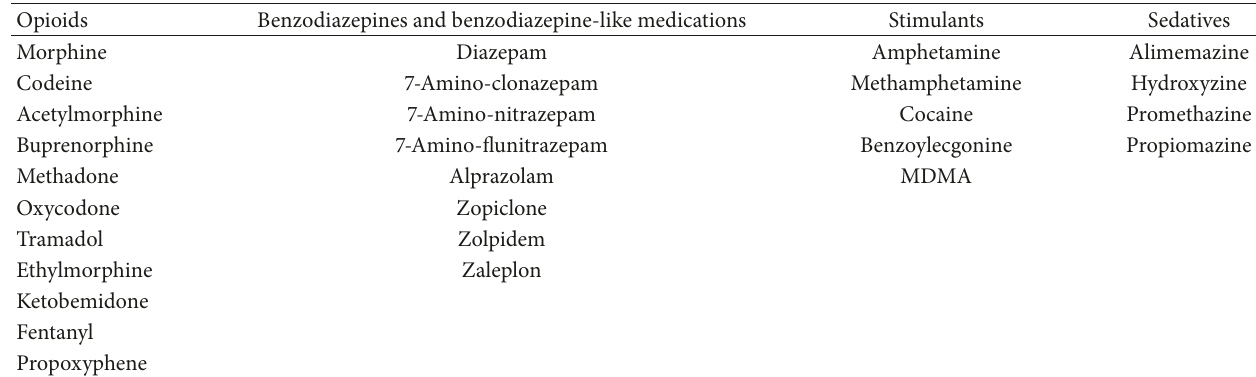
Table 1: Substances included in the quantitative method for drugs in hair.